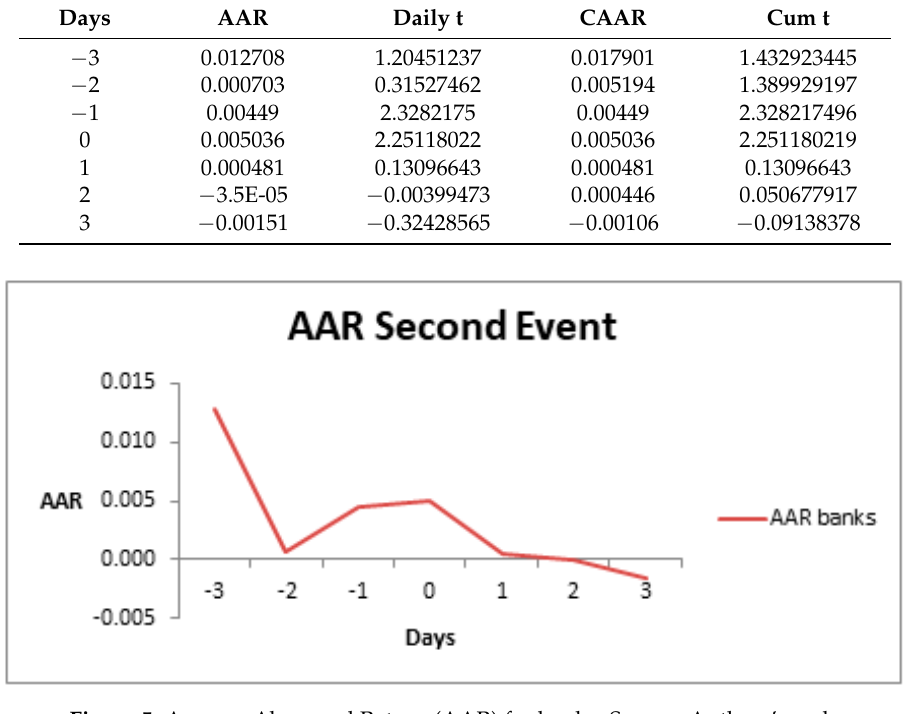
Figure 5. Average Abnormal Return (AAR) for banks. Source: Authors’ work. Table 4. Event study results of banks for the third event. Source: Authors’ work.